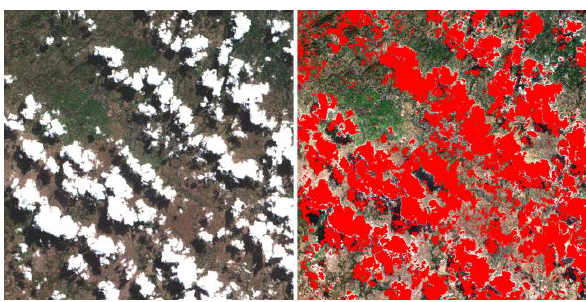
Figure 9. Squared sample of 20 km upon the sample image taken at July 17, 2018. (Left) Image before the masking algorithm; (right) Image masked based on the M2CTool Besides, the effectiveness of the algorithm is revealed by the analysis of the histograms of the frequency distribution (Shen et al., 2015) at each band (Figure 10). Either for high reflectance values (clouds), as well as for low values (shadows), which reasonably contaminate the scene, the tool shows good performance in terms of capability for masking clouds and cloud- shadows. Indeed, the solid line, i.e. the masked image, shows a significant decrease of the frequency at both sides (low and high values), and at each wavelength, with respect to the original unmasked image. However, the effect is most visible at the NIR band.